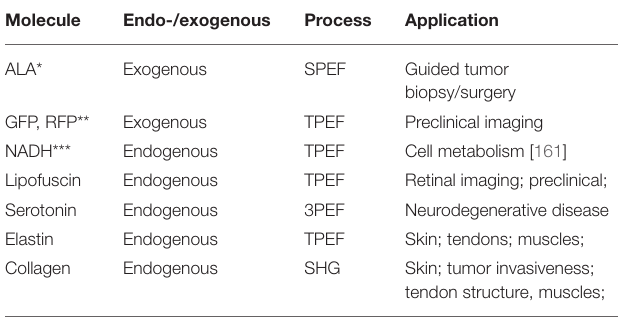
TABLE 4 | Typical molecules to be imaged by NLOM and MPM. Molecule Endo-/exogenous Process